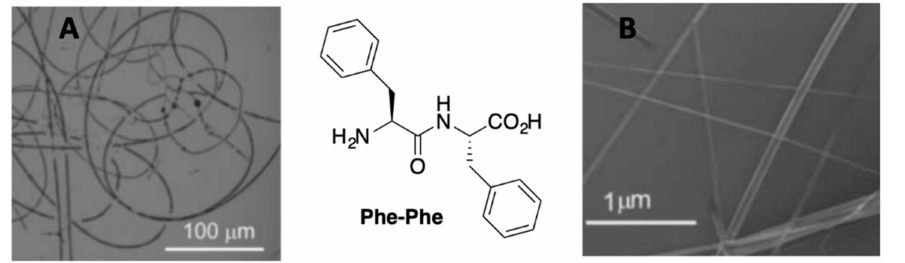
Figure 2. Phe-Phe electrospun nanofibers of ( A ) Phe-Phe self-assembled nanotubes of ( B ). Repro- duced from [24] with permission from John Wiley and Sons.